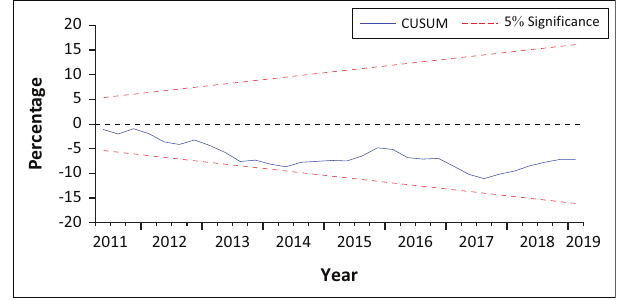
FIGURE 2: Model stability